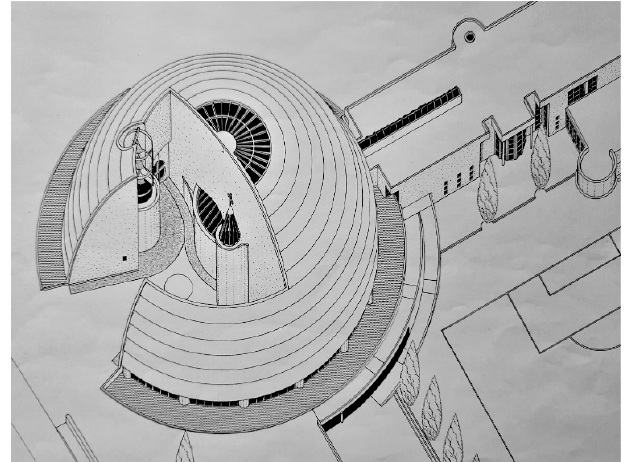
Figure 1. Axonometric plan of the church with the adjoining volume of the rectory on the north side.